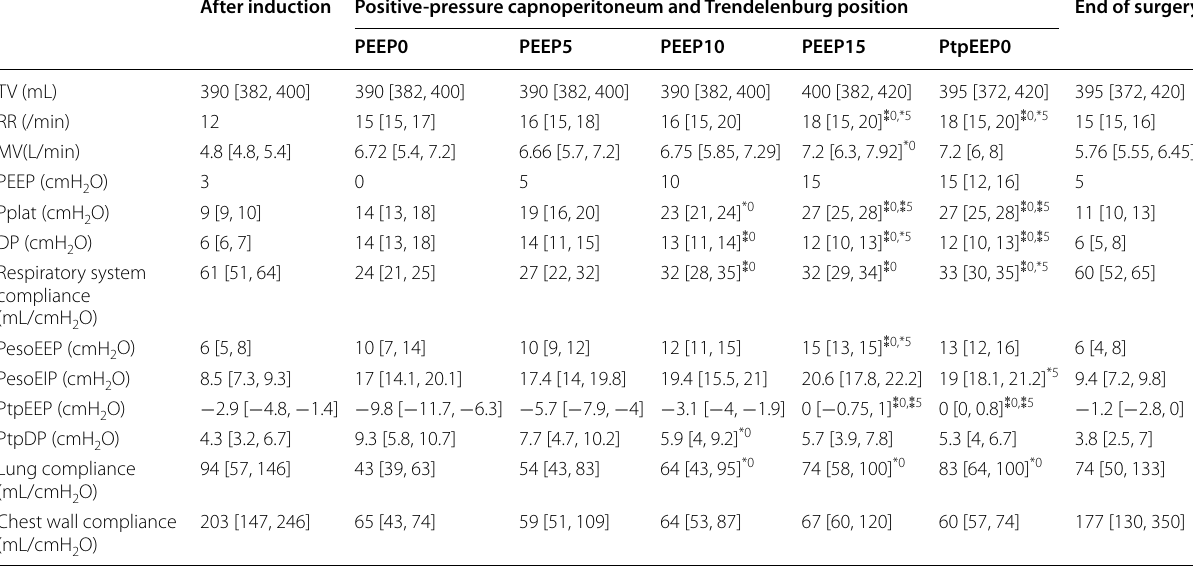
Data are presented as median values [interquartile range] TV tidal volume, RR respiratory rate, MV minute volume, PEEP positive expiratory pressure, Pplat inspiratory plateau pressure, DP driving pressure, PesoEEP end- expiratory esophageal pressure, PesoEIP end-inspiratory esophageal pressure, PtpEEP transpulmonary end-expiratory pressure, PtpDP transpulmonary